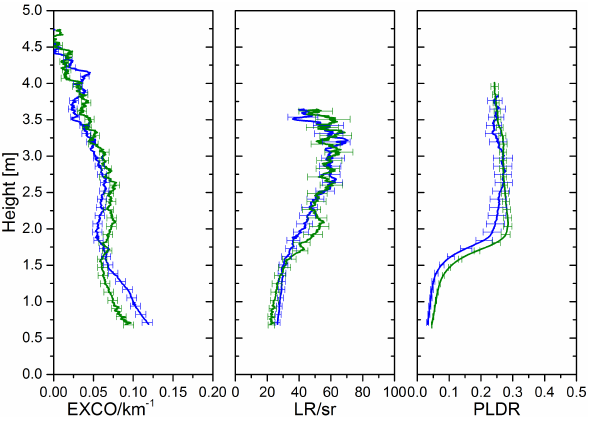
mean S p values of 30 ± 4 sr at 532 nm and 25 ± 2 sr at 355 nm are found. Mean δ p values are 0 . 06 ± 0 . 01 at 532 nm and 0 . 04 ± 0 . 01 at 355